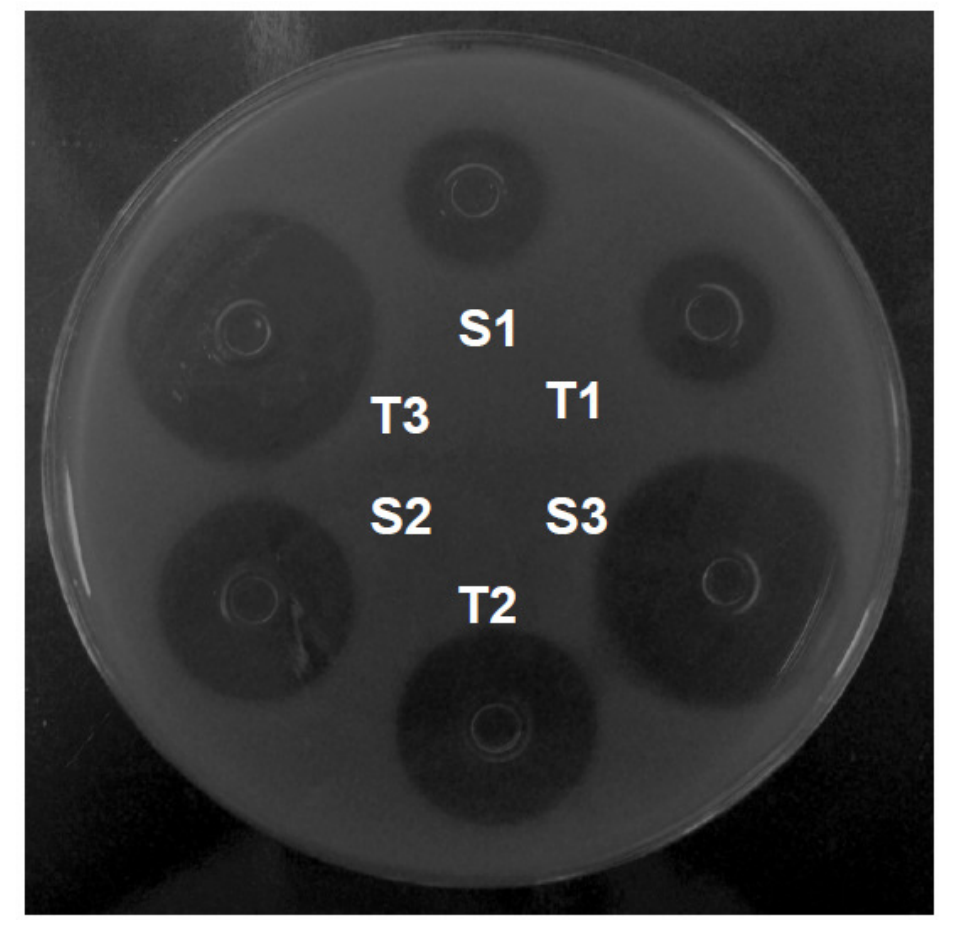
Figure 2. Agar diffusion assay (cylinder plate method) using a strain of S. aureus